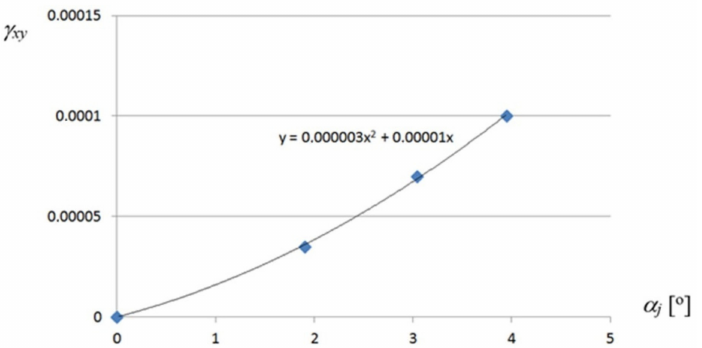
Figure A4. A nonlinear relation between the strains γ xy and α j unit angle at the crosswise ends of an effectively twisted